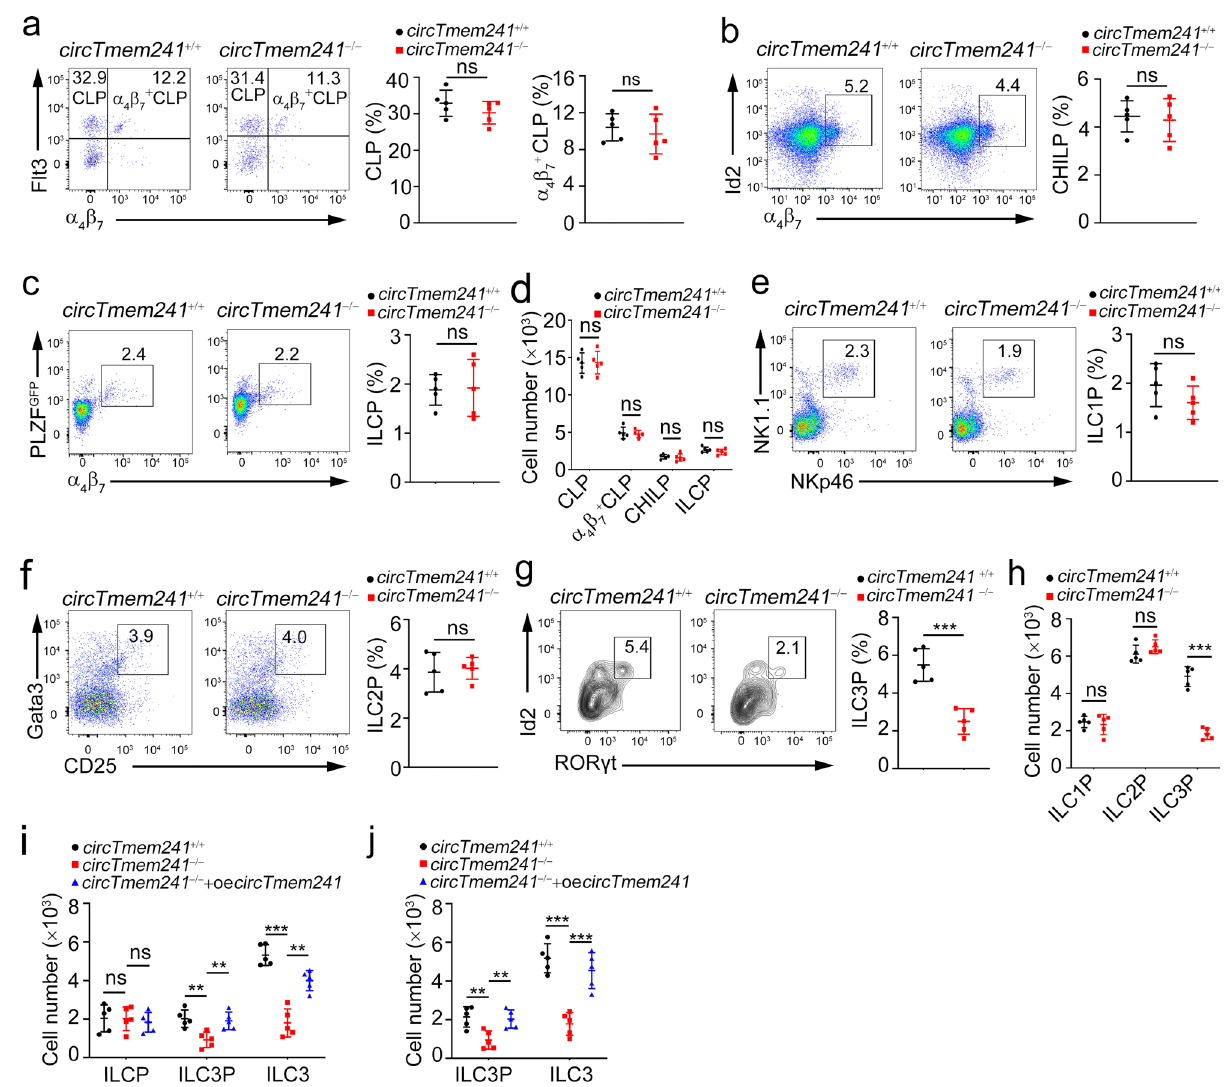
Fig. 2 | CircTmem241 drives ILC3 differentiation from the ILCP progenitor stage. a – c FACS analysis of circTmem241 +/+ and circTmem241 − / − ILC lineage progenitors. Plots displayed frequencies of CLPs (Lin − CD127 + c-Kit int Sca-1 int gated),